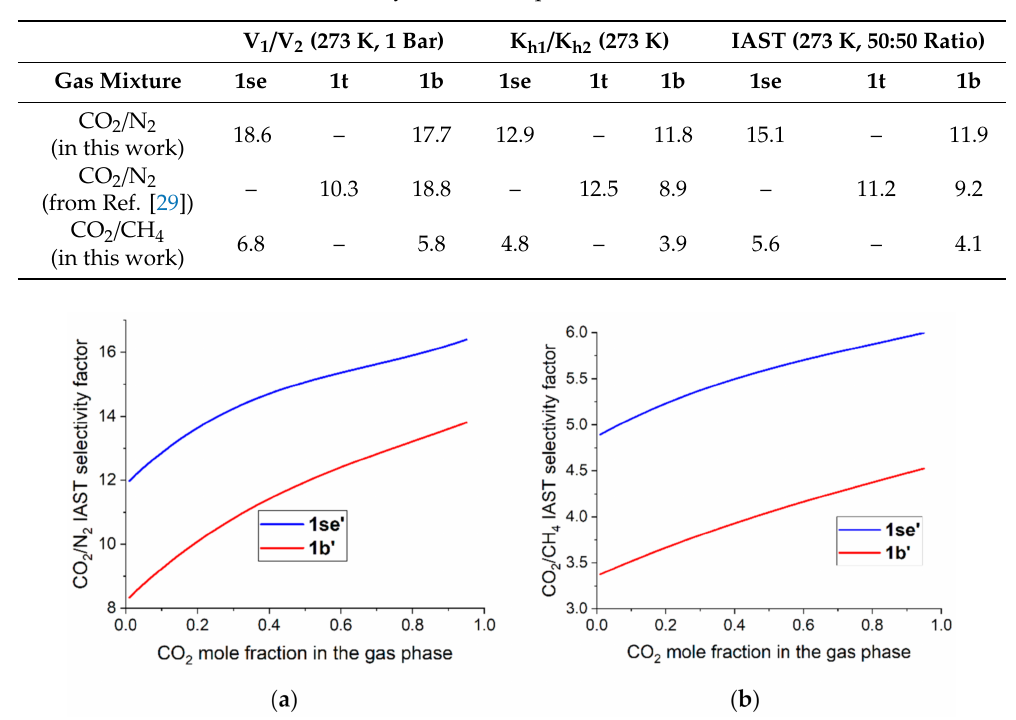
Table 1. Selectivities in binary gas mixtures calculated (I) as volumes ratio at 1 bar (II) as Henry constants ratio and (III) IAST selectivity factors for equimolar mixtures at 1 bar.